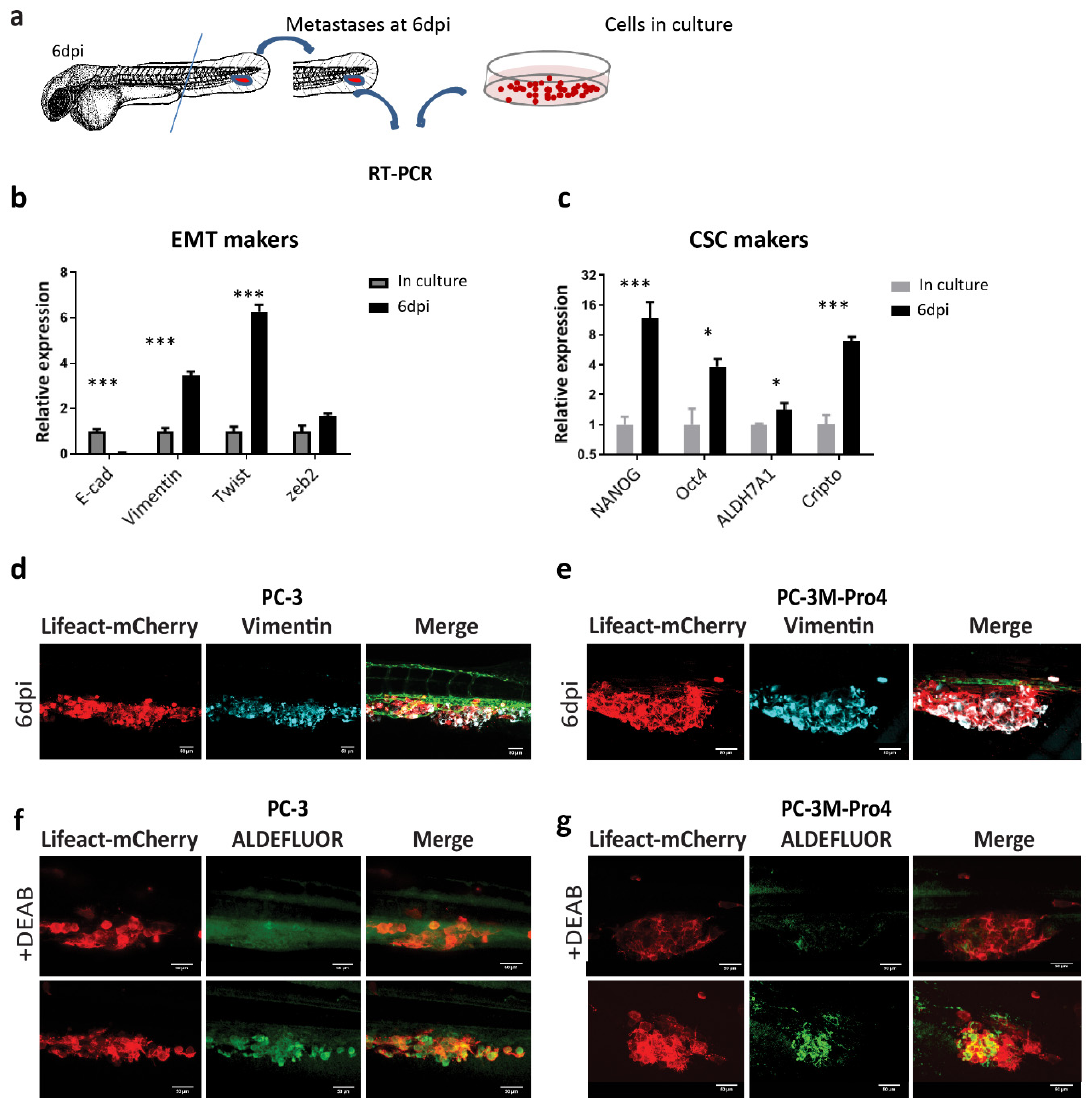
Figure 3. PCa cells obtain enhanced EMT and CSC traits after colonizing the ZF caudal hematopoietic tissue (CHT) area. ( a ) Schematic indication of RNA isolation from ZF metastases. At 6 dpi, ZF tails containing metastatic lesions were cut and collected for RNA isolation. ( b – c ) The expressions of EMT markers and stemness markers were compared in culture and in ZF metastases at 6 dpi. Experiments were independently repeated 3 times. Data were presented as mean ± SD ( d – e ) Immunofluorescence against vimentin on PC-3 and PC-3M-Pro4 in ZF metastases. ( f – g ) ZF engrafted with PC-3-lifeact-mCherry and PC-3M-Pro4-lifeact-mCherry was stained with ALDEFLUOR reagent with or without ALDH inhibitor DEAB at 4 dpi. Images were acquired using SP-8 confocal and processed with Fiji. Scale bar = 50um. Five fish were stained for each group.